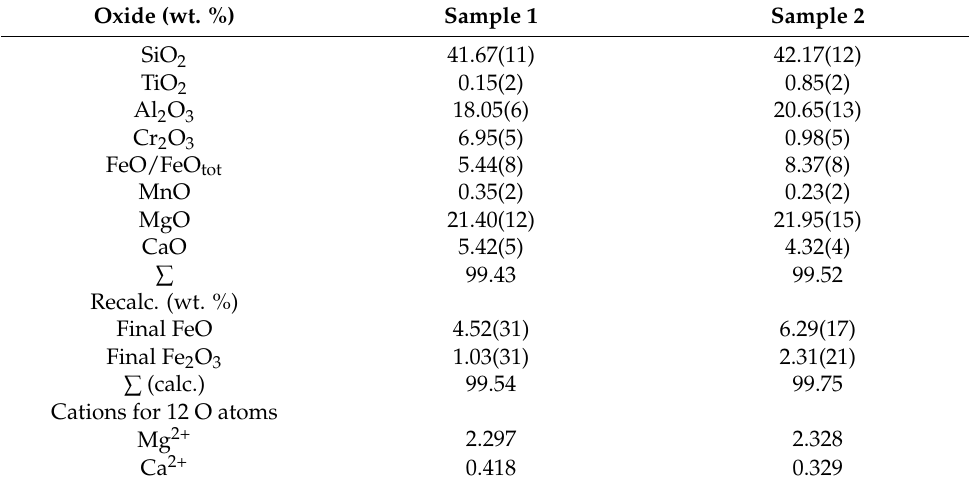
Table 1. Average EPMA results for two different pyrope samples. Oxide (wt.